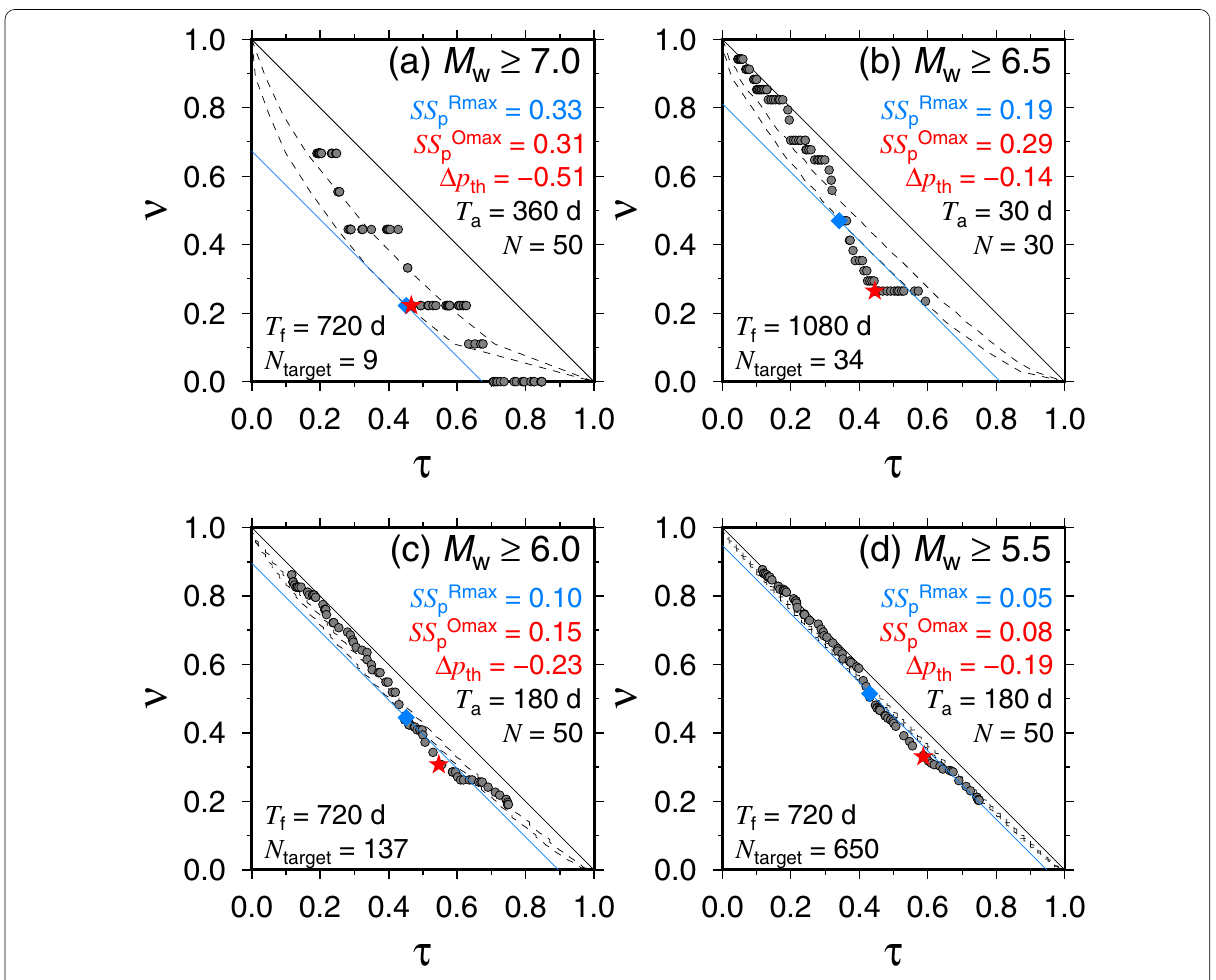
Fig. 5 Molchan’s error diagrams as in Fig. 4, but for forecasts based on the rate of change of the p